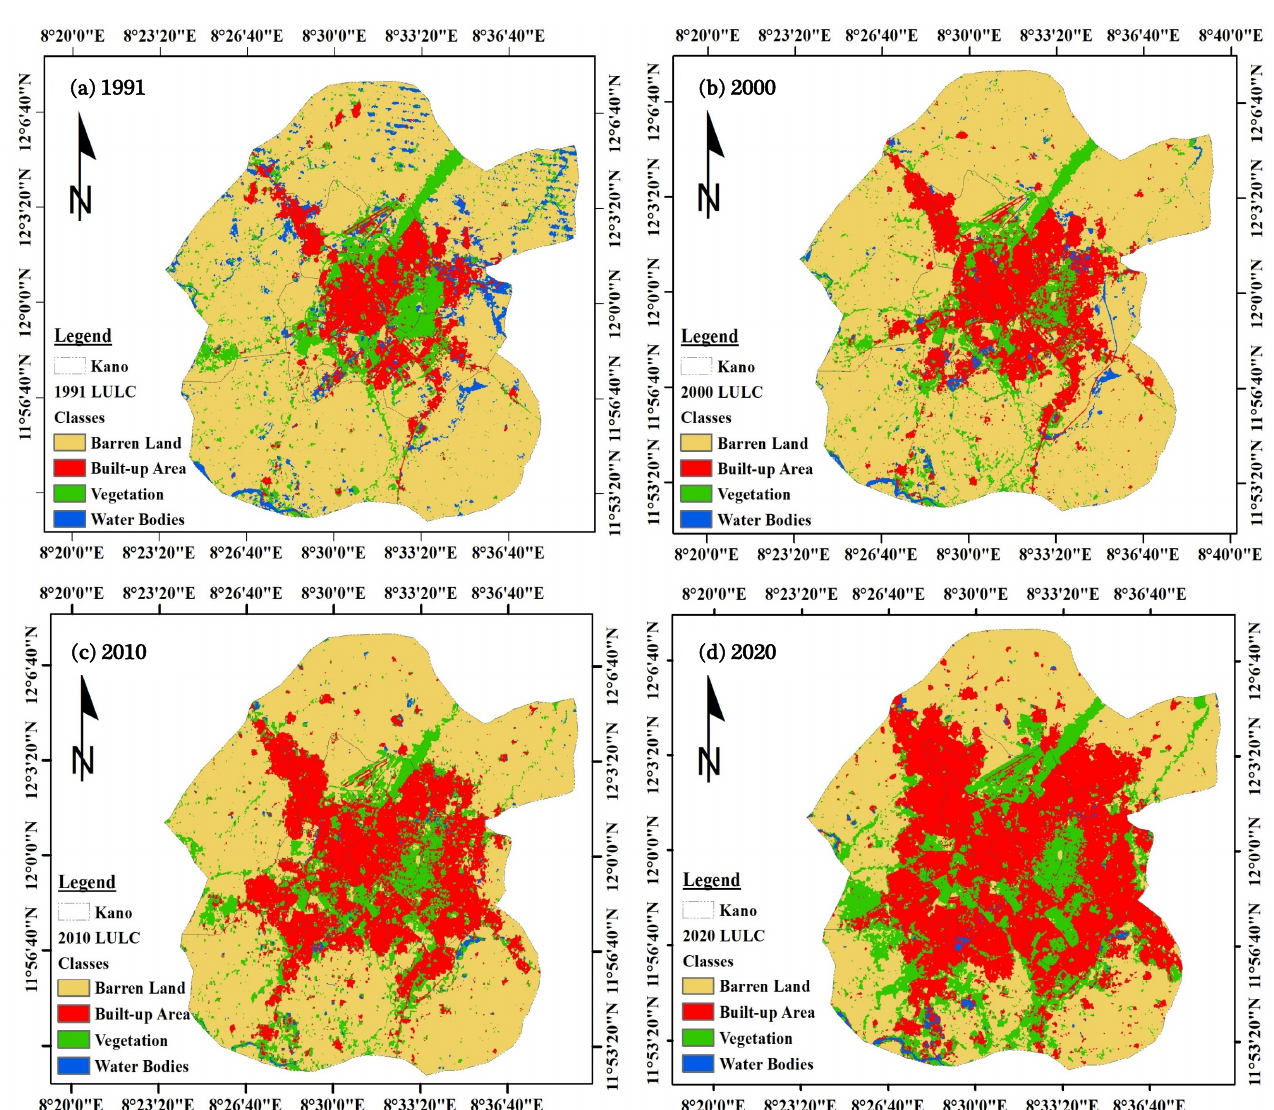
Figure 3. Classified LULC of the study area, i.e., Kano metropolis in ( a ) 1991, ( b ) 2000, ( c ) 2010,